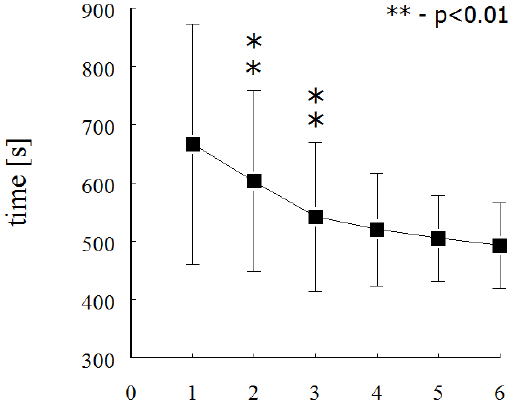
Figure 1. The results of 400 m front crawl swim test in 6 consecutive measurements in swimming group. The asterisks denote a statistical difference from the previous